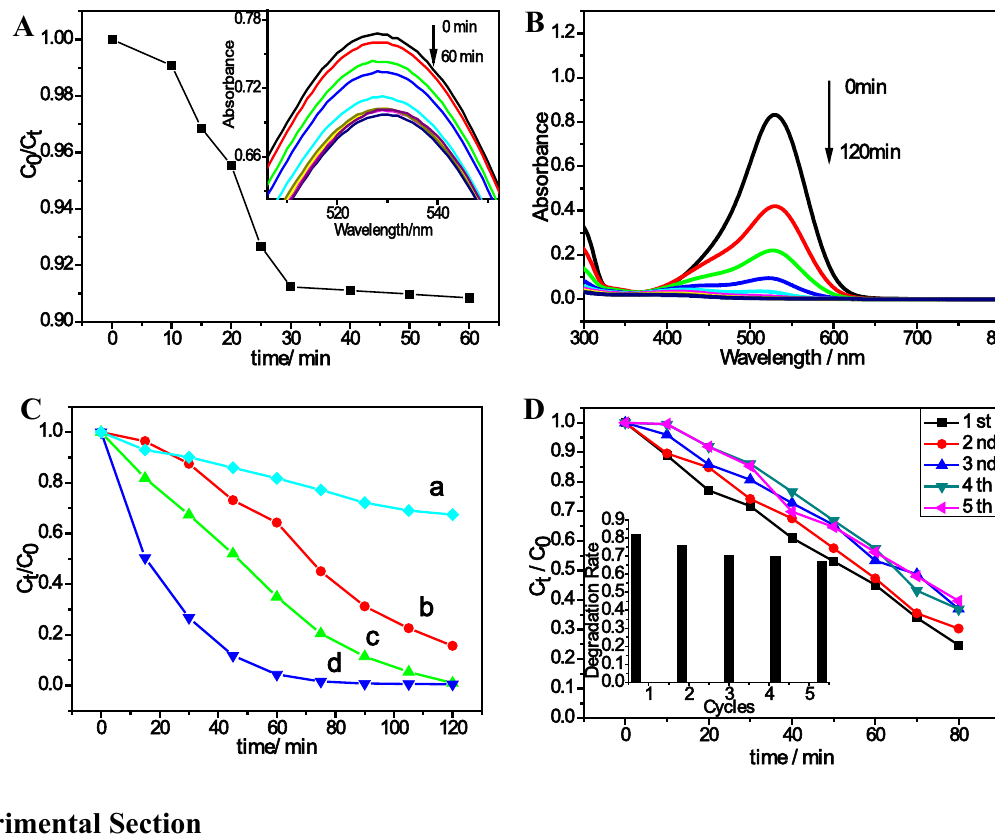
Figure 4. ( A ) The adsorption rate curves of neutral red test in the dark with the presence of Fe O @TiO . The insert is the adsorption curves of neutral red in the dark with 3 4 2 the presence of Fe O @TiO nanocomposites; ( B ) the photodegradation curves of 3 4 2 neutral red under visible light in the presence of Fe photodegradation rate curves of neutral red test in presence of only visible light without catalyst (a) and under the visible light irradiation with Sample-2 (b), P25 (c) and Fe O @TiO nanocomposites (d); ( D ) the degradation rate of the neutral red by 3 4 2 Fe O @TiO nanocomposites. The insert is the normalized rate constant in different 3 4 2